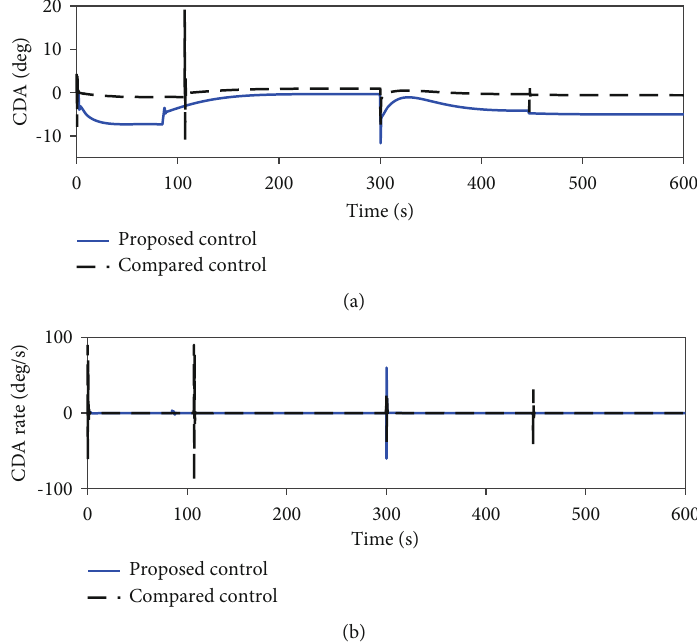
: (a) FER; (b) state of the auxiliary system. V